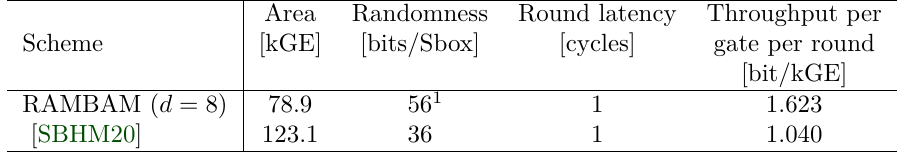
Table 2: AES-128 realization area and performance comparison for schemes with 16 Sboxes Area